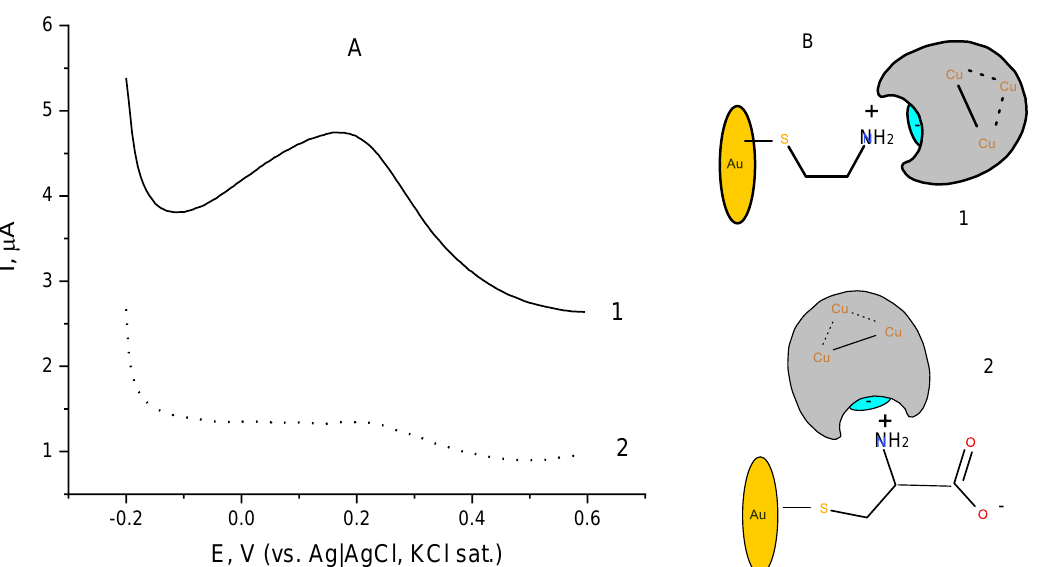
Figure 3. ( A ) Differential pulse voltammograms of laccase immobilized on chemisorbed monolayer of (1) cystamine and (2) cysteine; background electrolyte: 0.05 M citrate buffer, pH 4 containing 0.1 M NaClO 4 ; ( B ) Schematic of laccase orientation upon immobilization over a self-assembled monolayer of (1) cystamine and (2) cysteine residues.